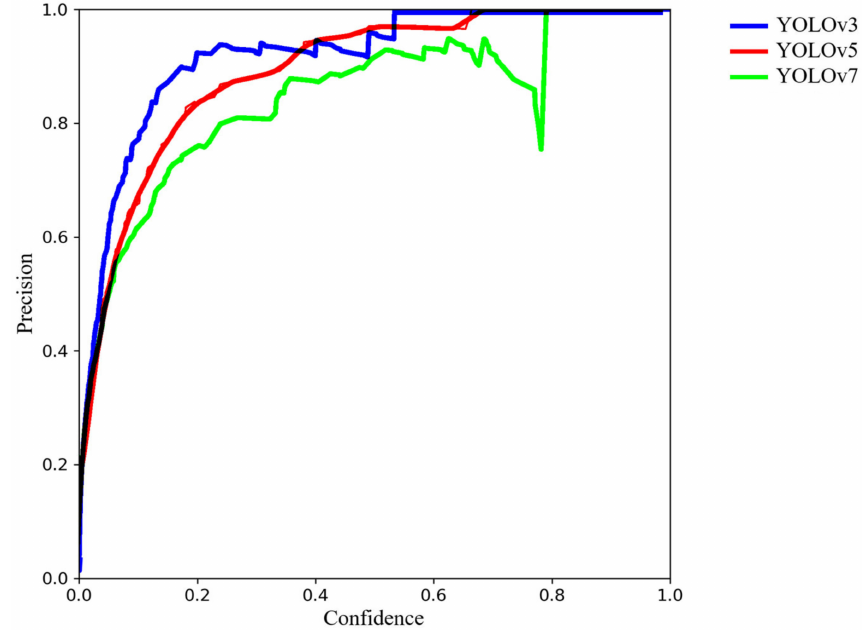
Figure 15. Precision-confidence